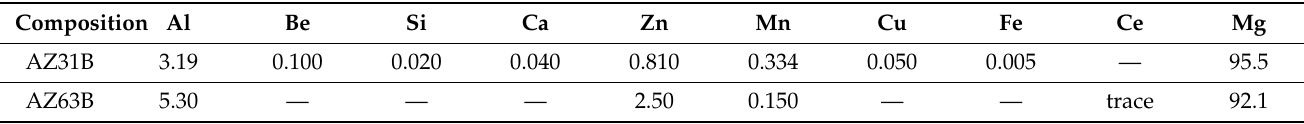
Table 1. The chemical composition of two Mg alloy sacrificial anodes (wt.%). Composition Al Be Si